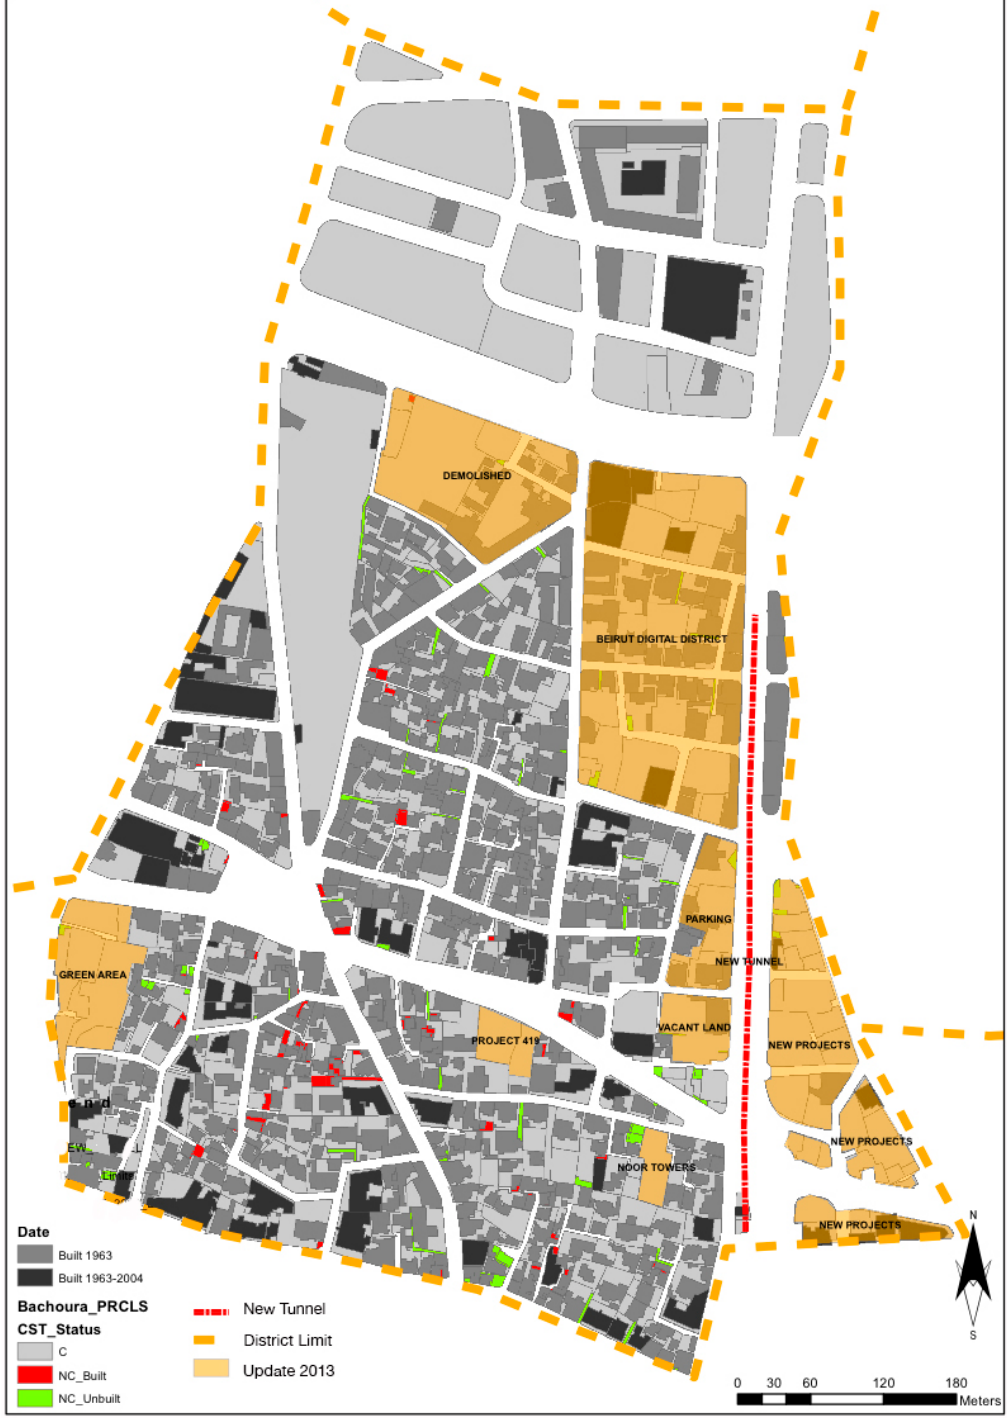
Figure 1. Non-Constructible parcels map within the Bachoura District [45].